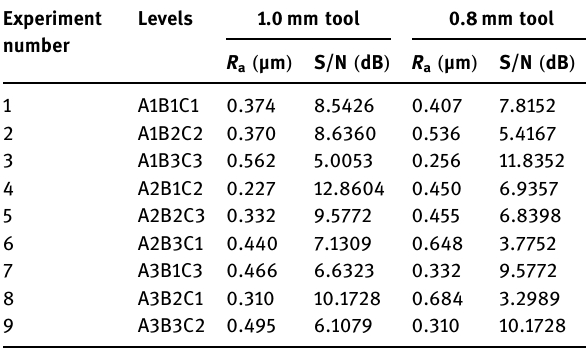
Table 4: Surface roughness and S/N values